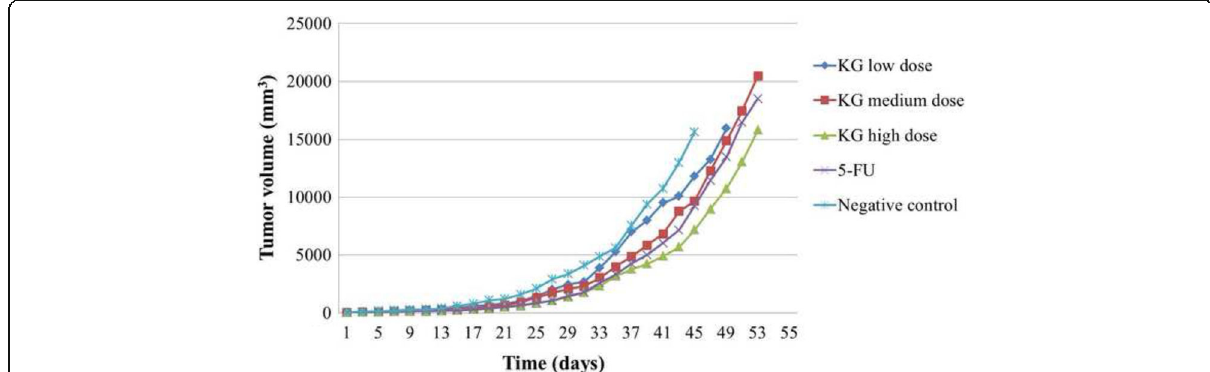
Fig. 2 Anti-CCA activity and tumor volume (TV) progression (mm 3 ) in CCA (CL6)-xenografted nude mice following initiation of treatment with K. galanga Linn. extract at high (1000 mg/kg body weight), medium (500 mg/kg body weight), and low (100 mg/kg body weight) dose levels versus the control groups (vehicle treated and 5-FU treated) during the investigation period. Treatment was started on day 7th after tumor transplant induction. Median survival time of the CCA-xenografted nude mice treated with the high dose extract [1000 mg/kg body weight: 62 (53.2 – 71.8) days] and 5-FU [59.0 (55.0 – 63.0) days] were significantly longer than the untreated control mice [49 (54.4 – 52.6) days]. Each data point is the median value of 6 tumors (from 3 male and 3 female mice) for each treatment